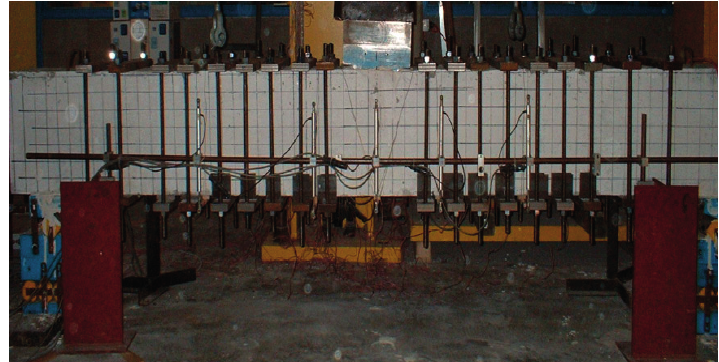
Figure 5. Typical test